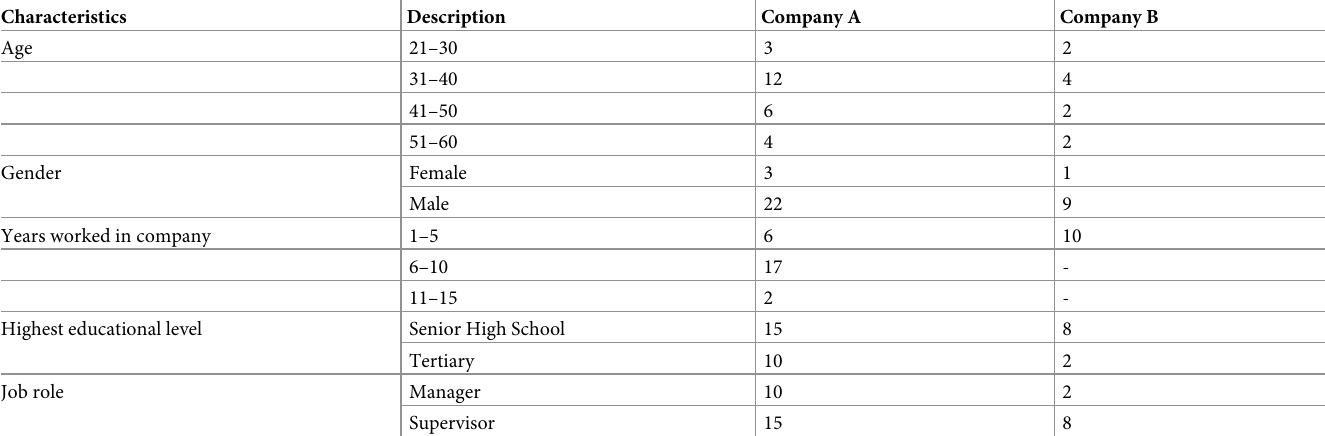
Table 2. Socio-demographic characteristics of